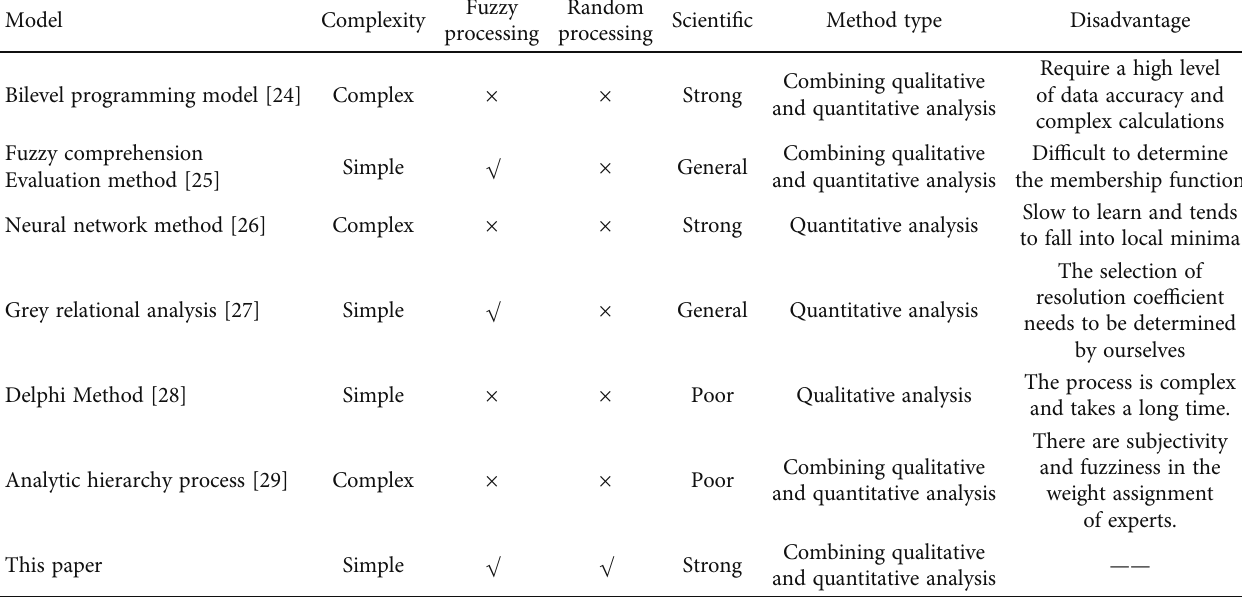
Table 1: Comparison of advantages and disadvantages of various evaluation